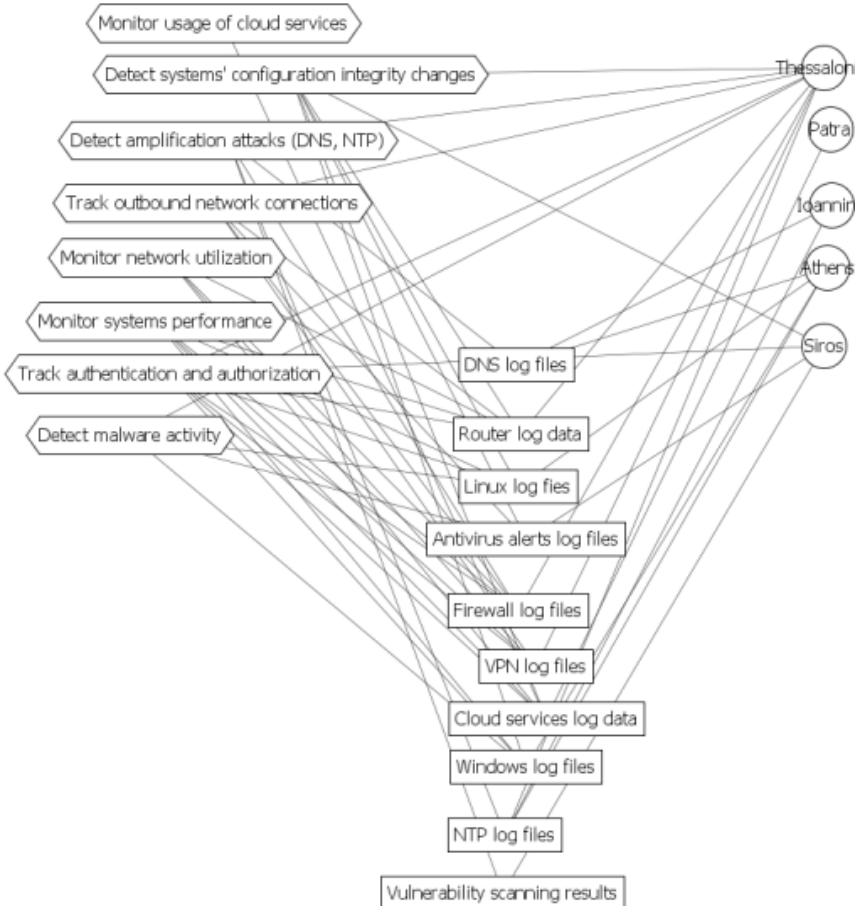
Figure 8. GRNET meta-network